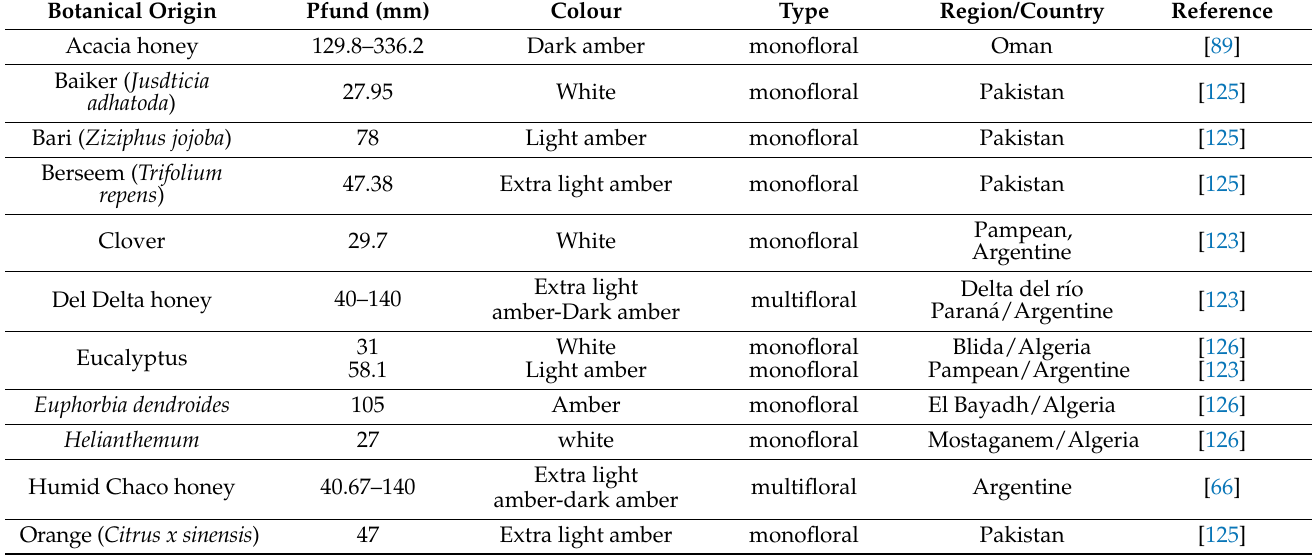
Table 2. Pfund values for monofloral and multifloral